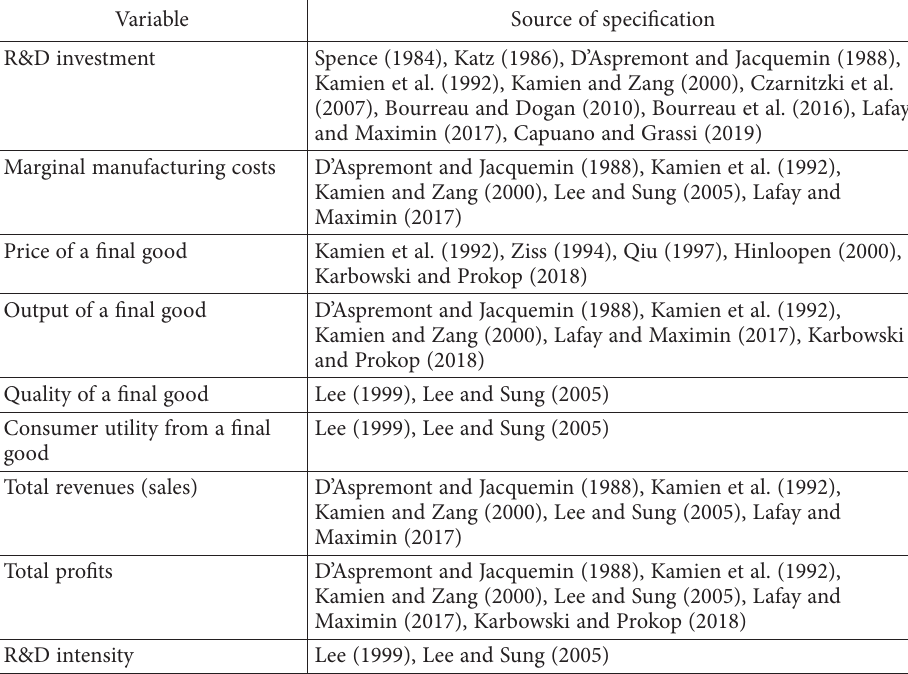
Table 2. The variables derived from the relevant studies Variable Source of specification R&D investment Spence (1984), Katz (1986), D’Aspremont and Jacquemin (1988), Kamien et al. (1992), Kamien and Zang (2000), Czarnitzki et al. (2007), Bourreau and Dogan (2010), Bourreau et al. (2016), Lafay and Maximin (2017), Capuano and Grassi (2019) Marginal manufacturing costs D’Aspremont and Jacquemin (1988), Kamien et al. (1992), Kamien and Zang (2000), Lee and Sung (2005), Lafay and Maximin (2017) Price of a final good Kamien et al. (1992), Ziss (1994), Qiu (1997), Hinloopen (2000), Karbowski and Prokop (2018) Output of a final good D’Aspremont and Jacquemin (1988), Kamien et al. (1992), Kamien and Zang (2000), Lafay and Maximin (2017), Karbowski and Prokop (2018) Quality of a final good Lee (1999), Lee and Sung (2005) Consumer utility from a final Lee (1999), Lee and Sung (2005) good Total revenues (sales) D’Aspremont and Jacquemin (1988), Kamien et al. (1992), Kamien and Zang (2000), Lee and Sung (2005), Lafay and Maximin (2017) Total profits D’Aspremont and Jacquemin (1988), Kamien et al. (1992), Kamien and Zang (2000), Lee and Sung (2005), Lafay and Maximin (2017), Karbowski and Prokop (2018) R&D intensity Lee (1999), Lee and Sung